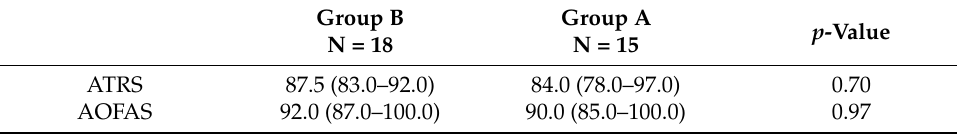
Values are medians